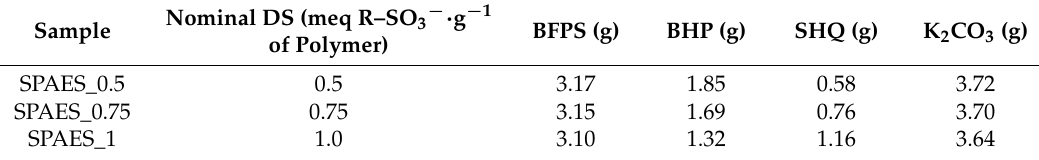
Table 1. Loading of the reagents for SPAESs with different